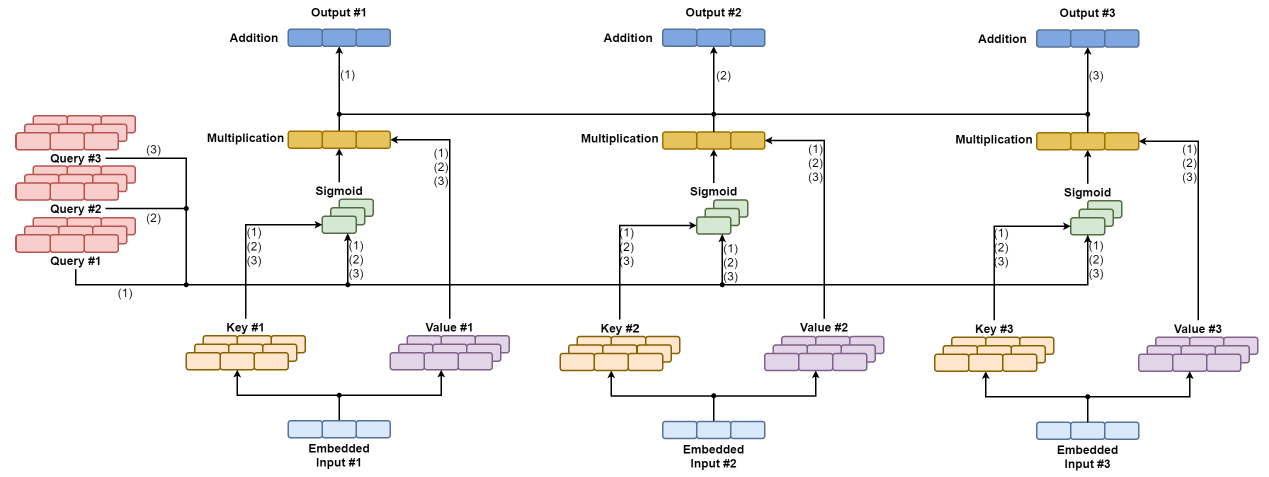
Figure 4. Attention score example of three embedded